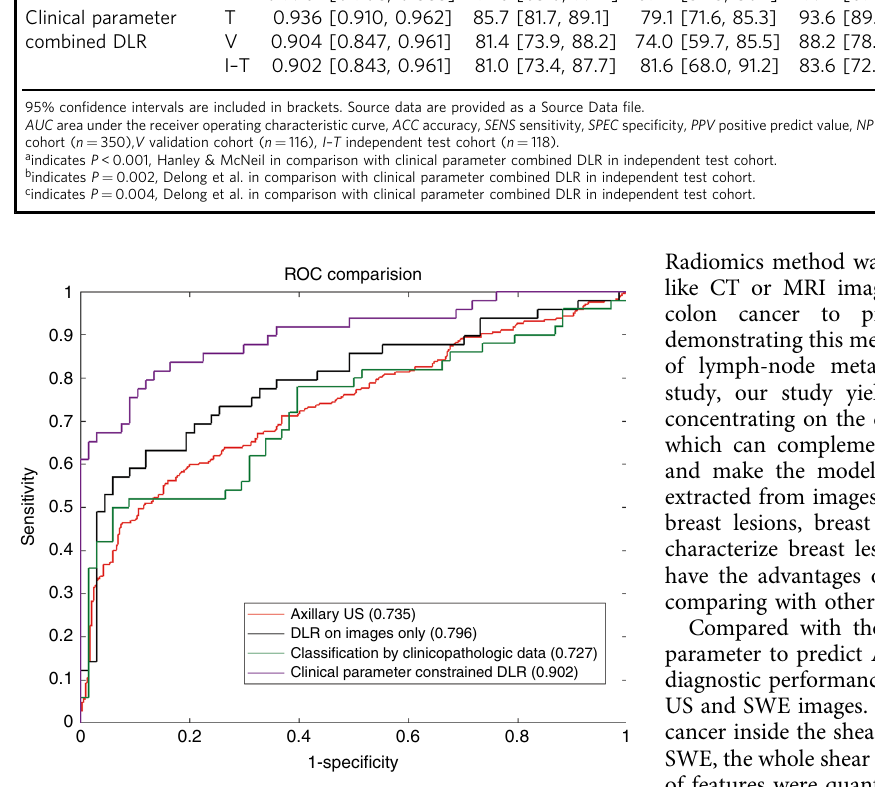
Fig. 2 Comparison of receiver operating characteristic (ROC) curves between different models for predicting disease-free axilla (N0) and any axillary metastasis (N + ( ≥ 1)). DLR deep learning radiomics. Numbers in parentheses are areas under the receiver operating characteristic curves. Source data are provided as a Source Data fi